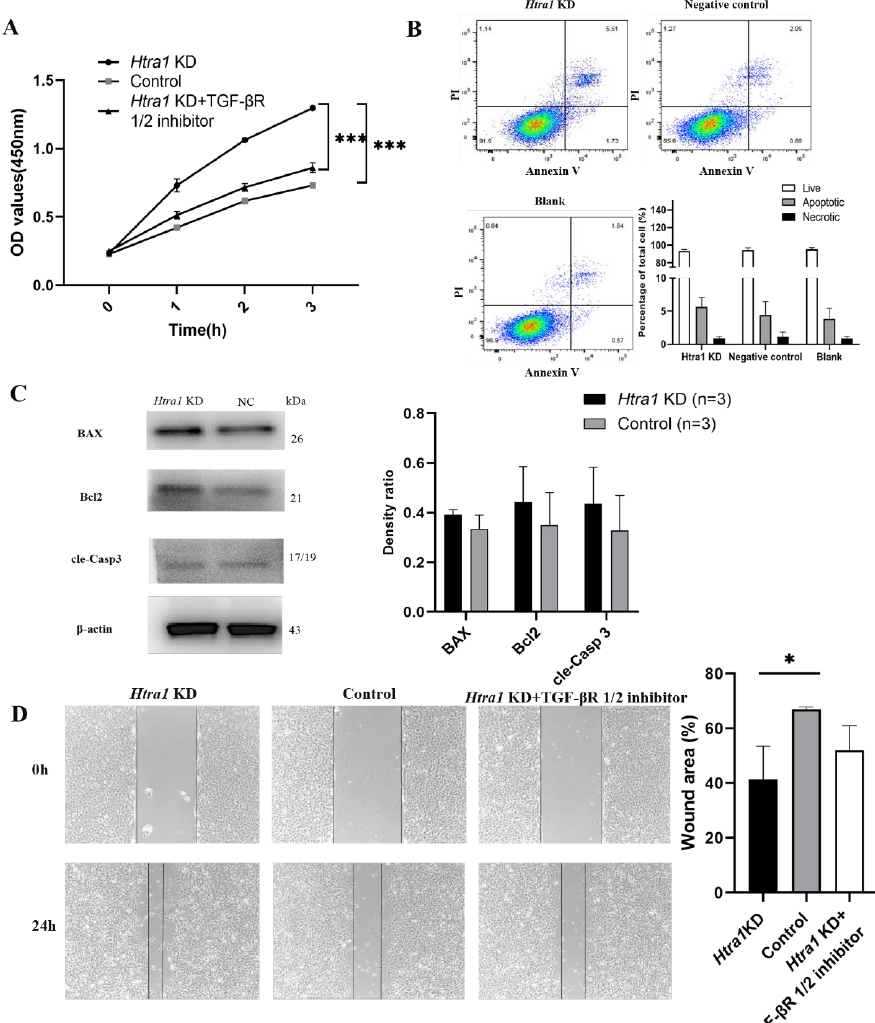
Figure 5. The proliferation, migration and apoptosis changes of HLECs (SRA 01/04) after treatment of HTRA1 knockdown. ( A ) CCK-8 assay showed promoted growth ability of HLECs after downregulated expression of HTRA1 ( p < 0.001) and was attenuated after treatment of HTRA1 knockdown and the TGF- βR1/2 inhibitor ( p < 0.001). ( B ) Annexin V/7-AAD staining and flow cytometry did not show significant apoptotic cell changes after treatment of HTRA1 knockdown. ( C ) The protein levels of BAX, Bcl2 and cleaved Caspase-3 in HLECs after treatment of HTRA1 knockdown ( p >